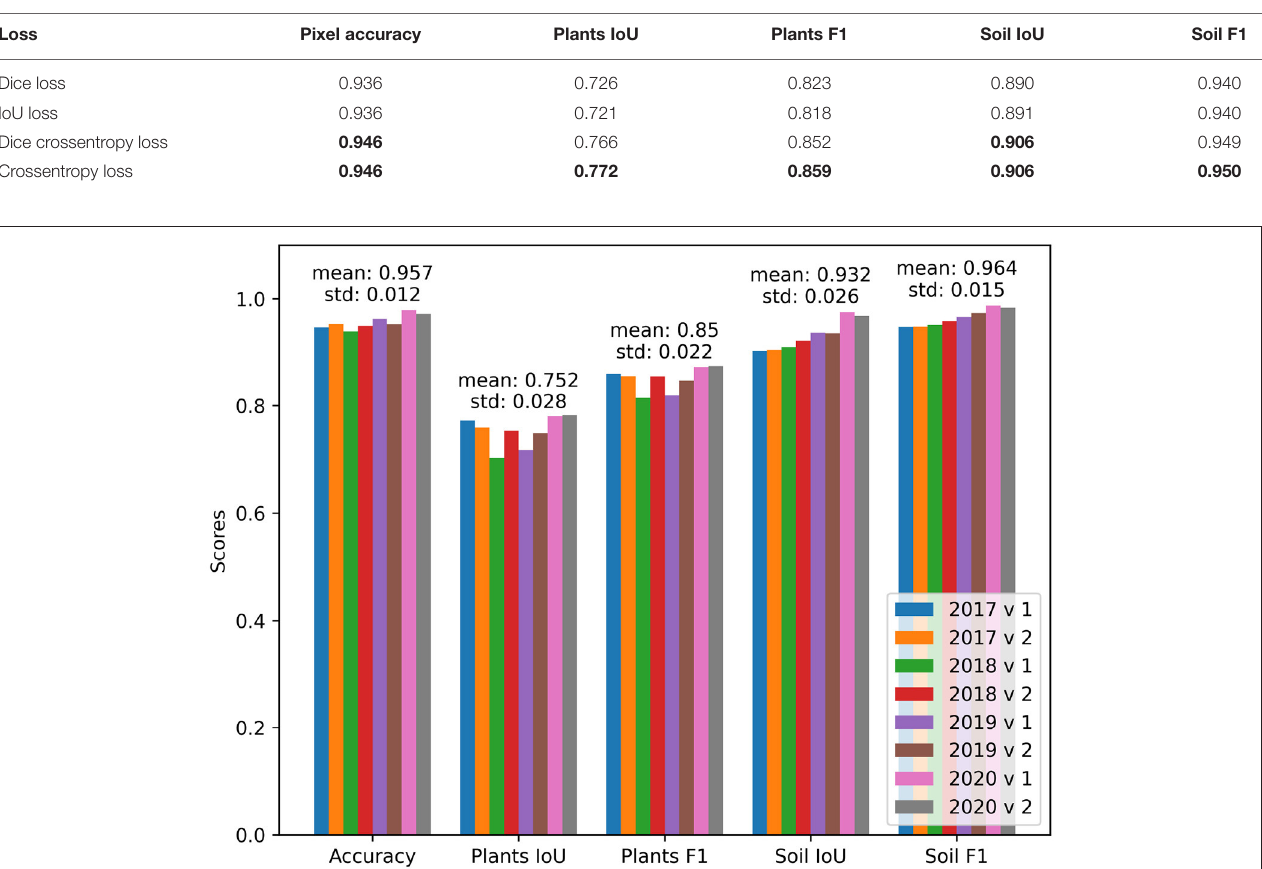
TABLE 6 | Testing of various